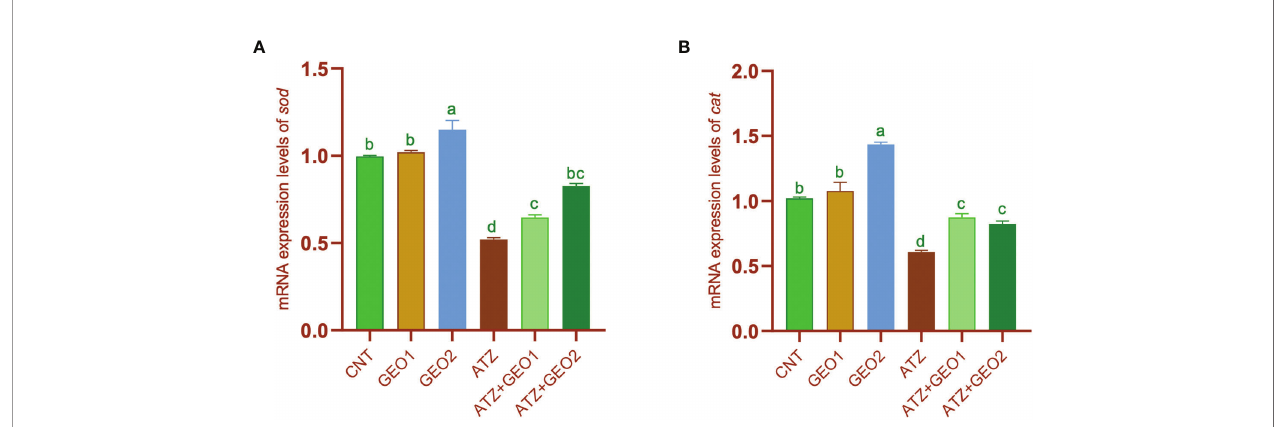
FIGURE 6 | mRNA expression levels of sod (A) and cat (B) genes relative to b -actin gene in the hepatic tissues of Nile tilapia in response to sub-lethal ATZ exposure and/or dietary supplementation with GEO for 60 days. Values are expressed as means ± S.E.M (n = 9). Values that are not sharing a common letter differ signi fi cantly at P <